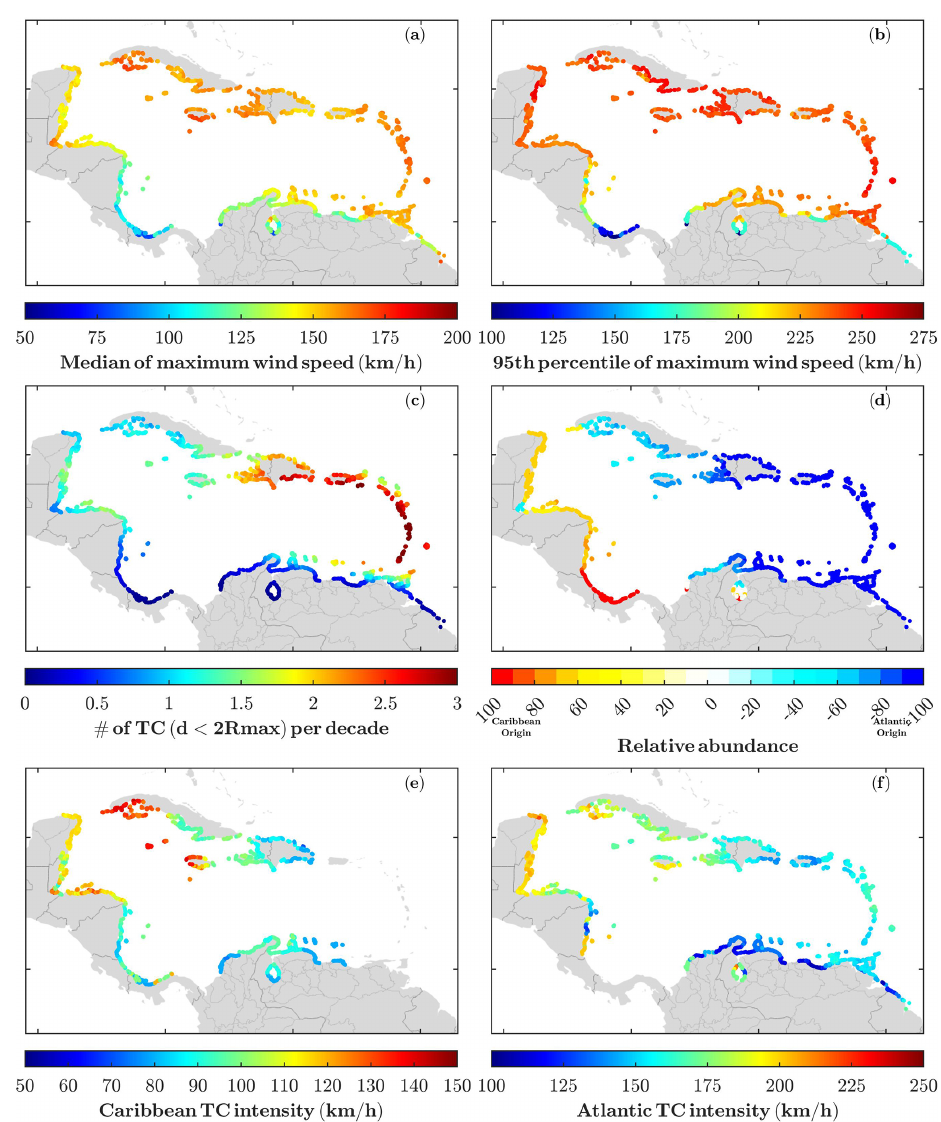
Figure 3. Characteristics of TCs affecting the Caribbean coasts. The top panels (a, b) show the intensity of the selected subset of TCs in terms of the mean and the 95th percentile of the maximum wind speed when they reach the coastline. Panel (c) shows the number of TCs per decade affecting each coastline, considering that a coastal grid point is affected if it is within a radius smaller than twice R max . Panel (d) represents the family of TCs (Atlantic or Caribbean) that most affect every grid point in percentage. In this way, 0 is obtained if both families affect equally, and in colour is the percentage of the one that affects more. The entire red zone is dominated by TCs generated in the interior of the Caribbean Sea, while the blue zone is more influenced by TCs of the Atlantic Basin. Finally, (e) and (f) show the median maximum wind speed of TCs from each